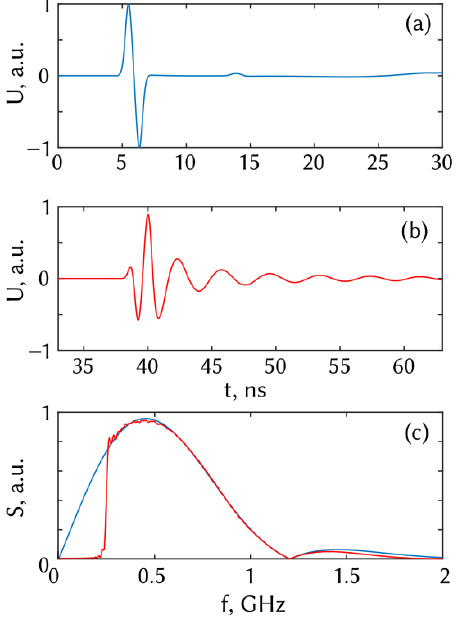
Figure 9. Waveforms of the voltage at the input ( a ) and at the output ( b ) of the coaxial line, filled with the plasma of density n e = 7.7 × 10 8 cm −3 , and corresponding frequency spectra ( c ). The voltage level at the input of the line is designated as 1.